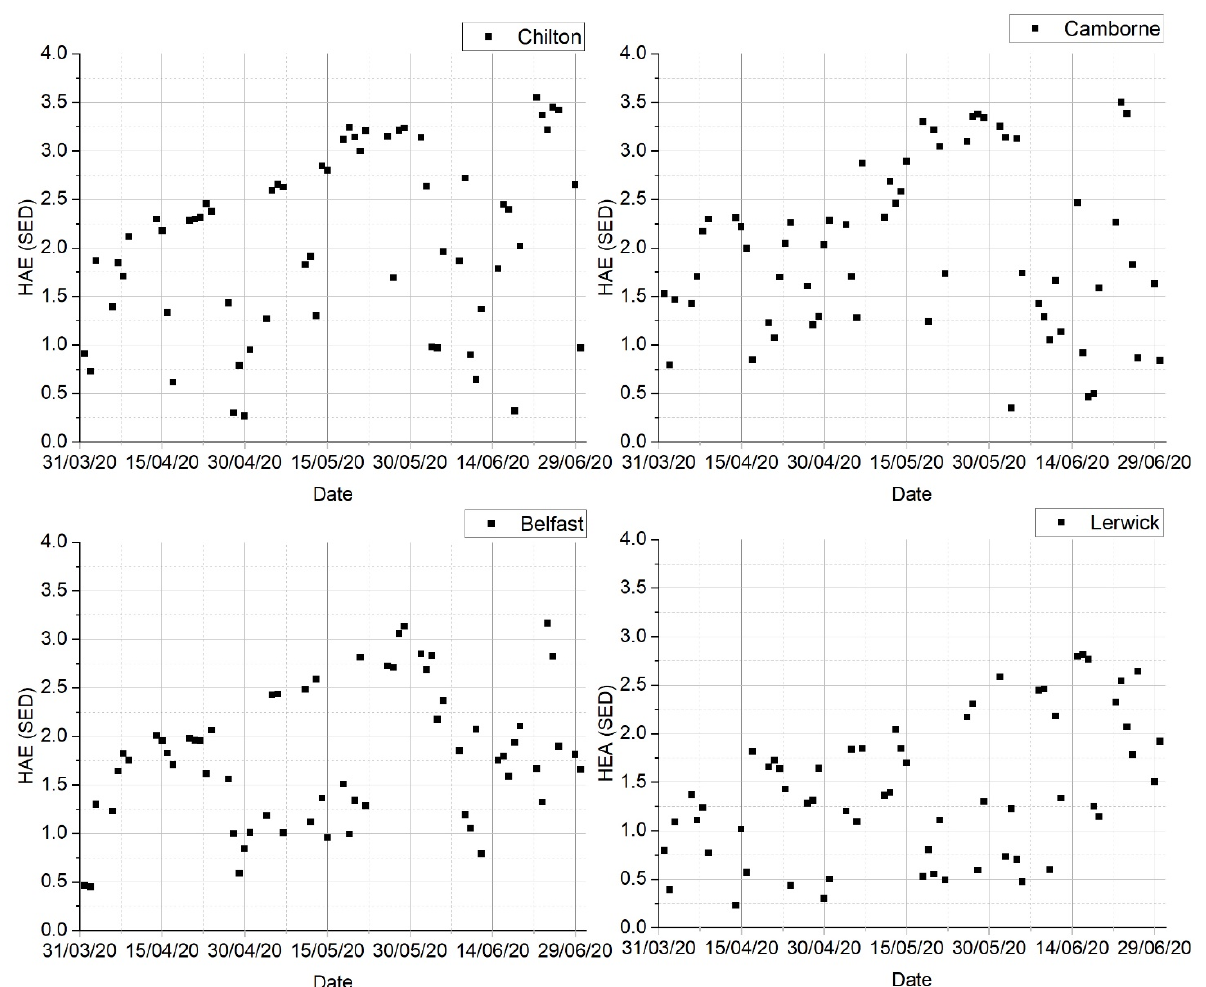
Figure 2. Available erythema effective radiant dose, H AE , in 30 min from 12:45–13:15 BST for Chilton, Camborne, Belfast, and Lerwick in April–June 2020.